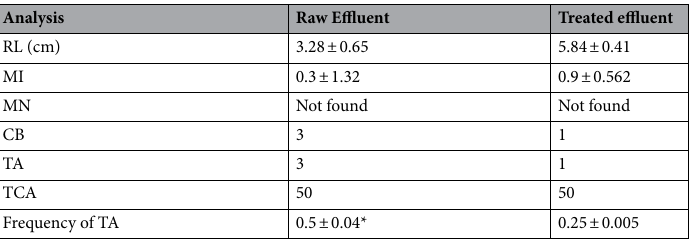
Table 3. Genotoxicity analysis for the raw and treated effluent. RL- root length; MI- Mitotic index; MN- micronuclei; CB- Chromosome breaks; TCA- total no. of cells analysed; TA-Total no. of alterations. Values are mean of three experiments, * P < 0.05, ** P < 0.001 by one-way analysis of variance (ANOVA) with Tukey– Kramer comparison